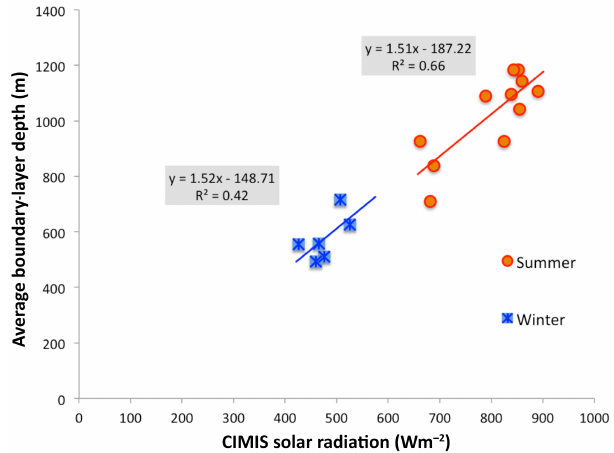
Figure 6. Flight averaged boundary-layer depths as a function of the surface downwelling solar radiation, as measured by the CIMIS station pyranometer in the flight regions near Fresno in winter, and Bakersfield in